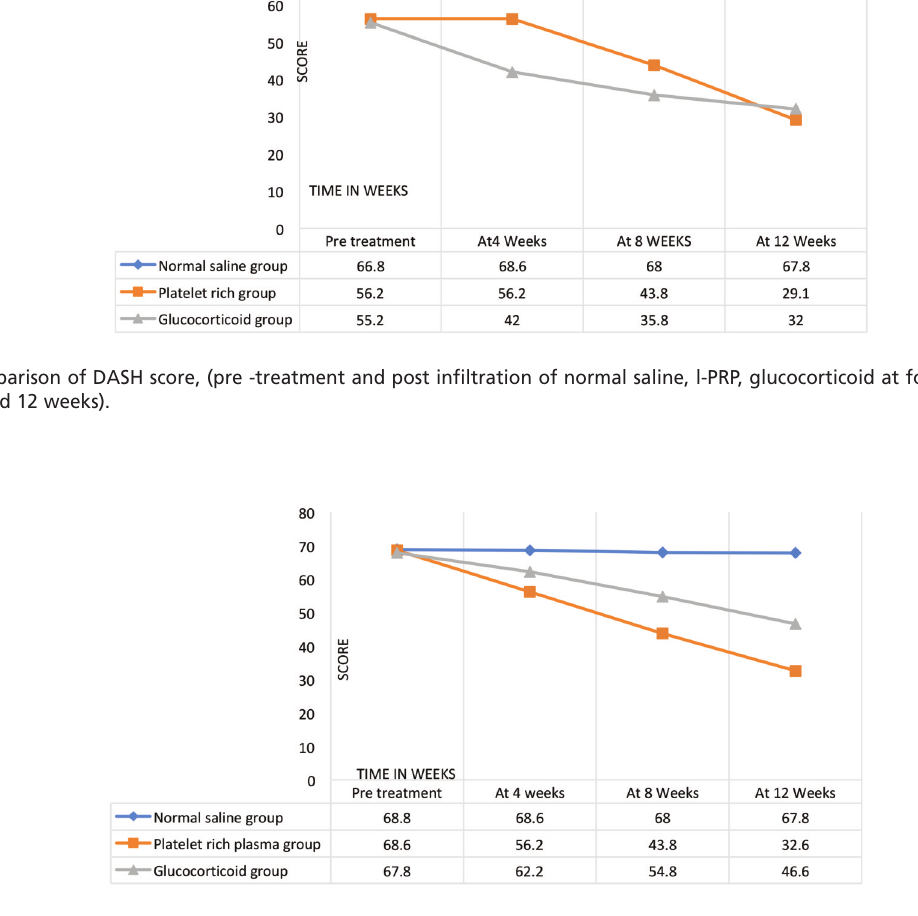
Comparison of PRTEE score, (pre-treatment and post infiltration of normal saline, l-PRP, glucocorticoid at follow-up visits of 4, 8, Fig. 5: and 12